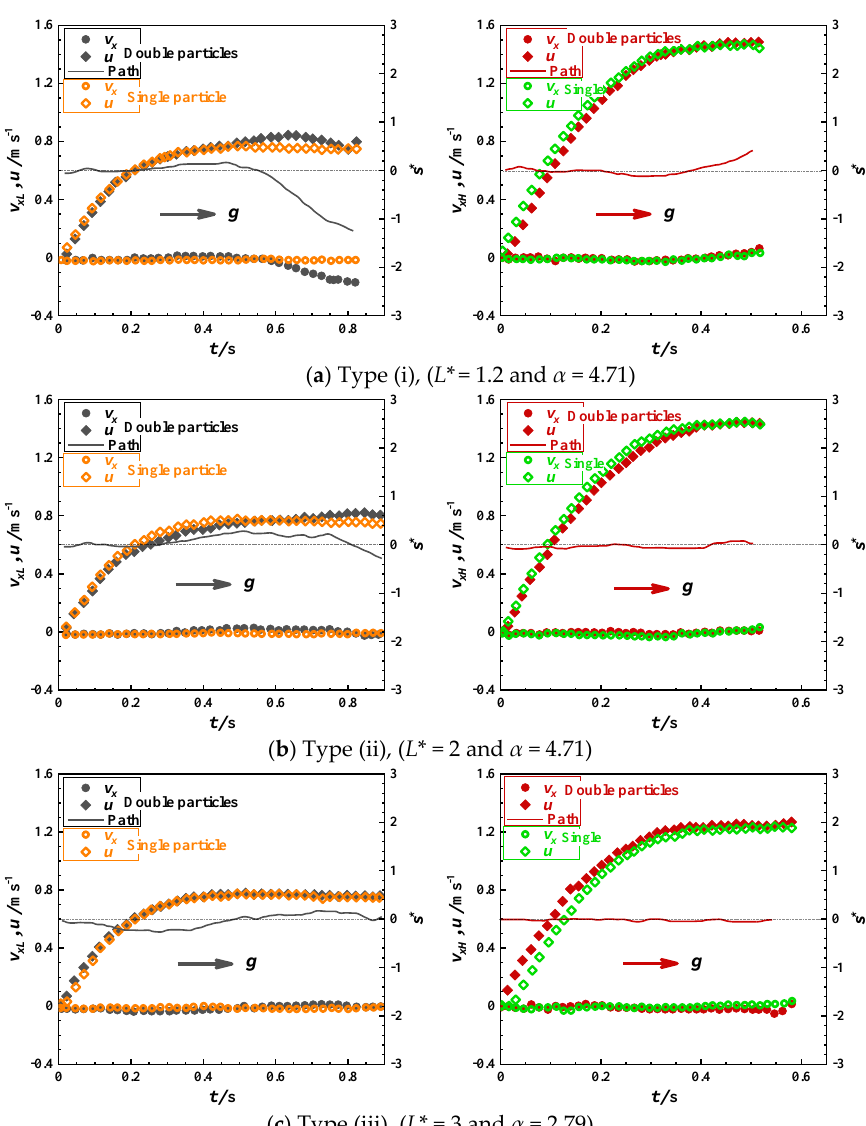
Figure 14. The velocities and the trajectories of the two side-by-side settling particles at different separation distance L *; Left: the light particle; Right: the heavy particle.